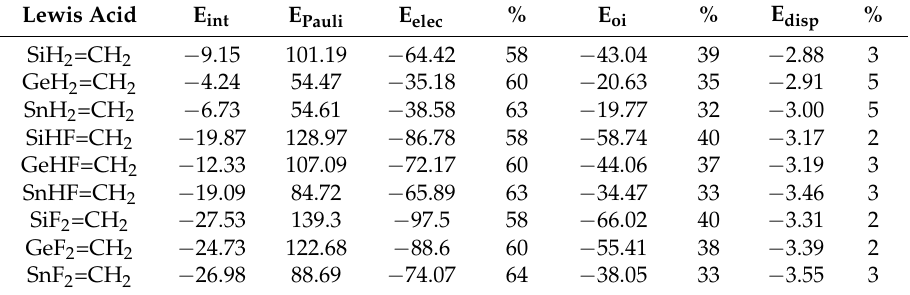
Table 7. EDA/BLYP-D3(BJ)/ZORA/TZ2P decomposition of the interaction energy of π -hole